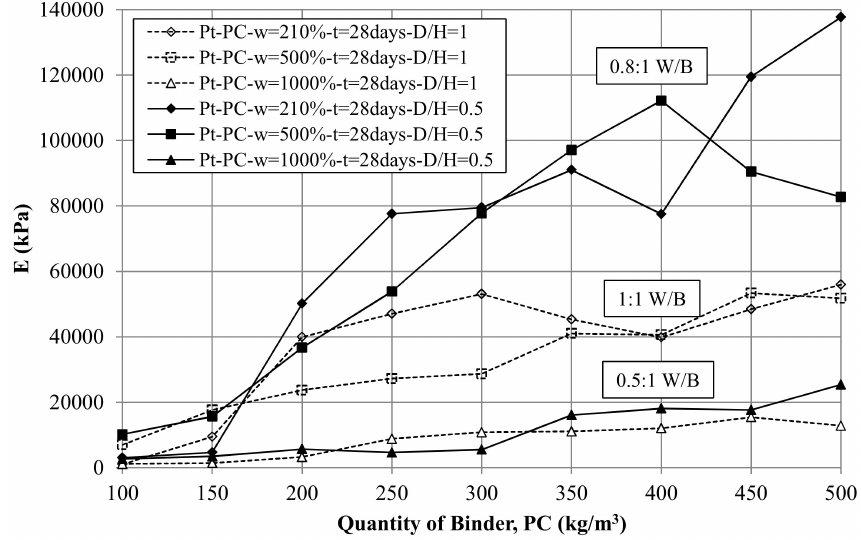
Figure 10. Effect of quantity of binder ( PC ) and water/binder ratio on E at 28